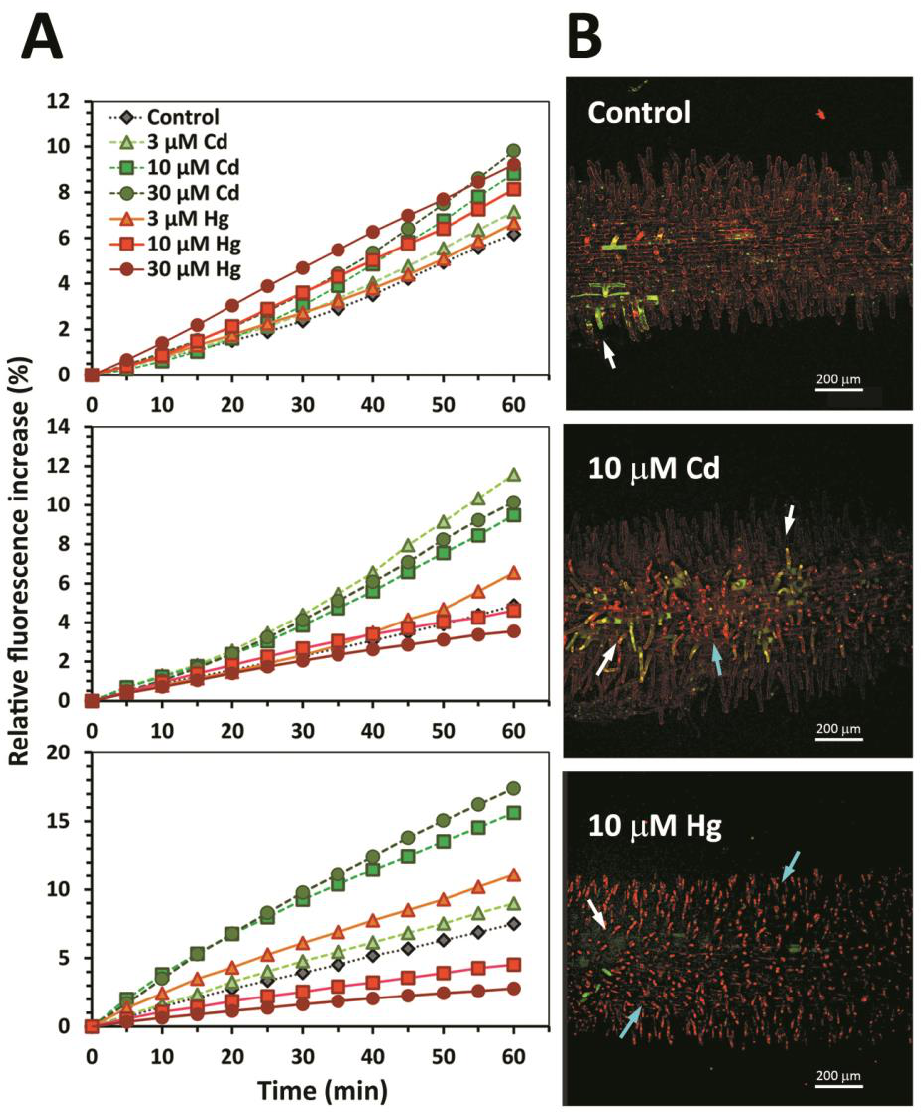
Figure 4. Generation of apoplastic H 2 O 2 in alfalfa root segments and induction of oxidative stress in alfalfa root epidermal cells. ( A ) Measurement of AmplexRed fluorescence (%, relative to time 0) of root segments ( n = 12 per treatment) collected from alfalfa seedlings treated with 0, 3, 10, and 30 µ M Hg or Cd for 3, 6, and 24 h. ( B ) Confocal fluorescence microscopy to detect oxidative stress (H 2 DCFDA, green pseudo-colour, white arrows) in alfalfa seedlings treated with control, 10 µ M Cd or 10 µ M Hg for 6 h. Seedlings were counterstained with propidium iodide (PI, red pseudo-colour) to highlight cell walls and necrotic cells with condensed nuclei (blue arrows). Representative images of at least three independent experiments are shown.